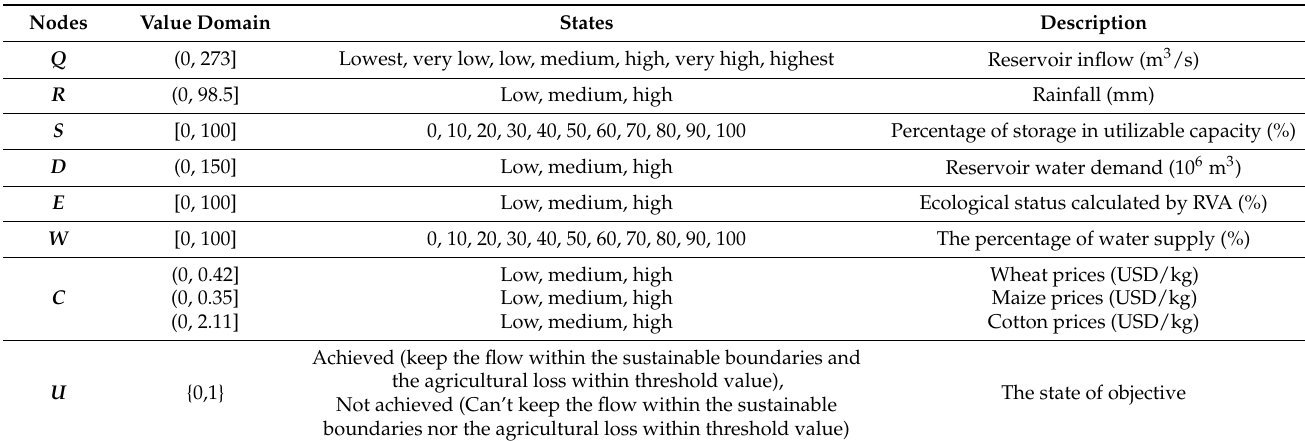
Table 2. Nodes of the DBN